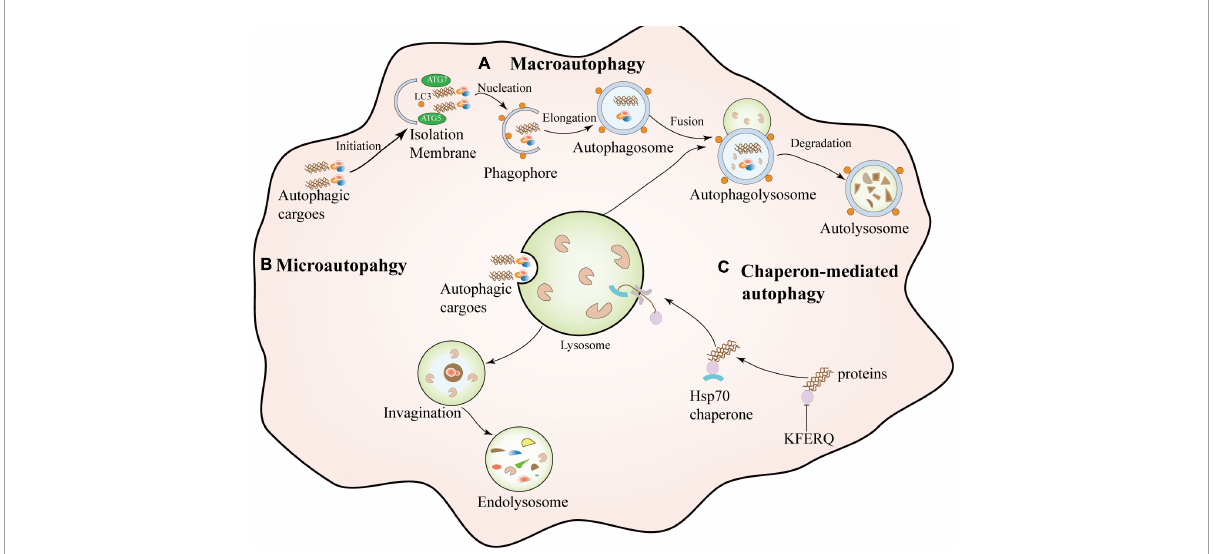
FIGURE1 Types of autophagy. Macroautophagy is a dynamic process characterized by the sequestration of cytoplasmic contents in a bilayer membrane structure, forming an intermediate structure called an autophagosome or autophagosome and then fusion with lysosomes for degradation. Microautophagy: It encapsulates contents by invagination on the lysosomal membrane to form an intrinsic vesicle followed by degradation. Chaperone-mediated autophagy (CMA) is a highly selective catabolic process that mediates specific target motifs containing CMAs. The protein (KFERQ) is dissociated by cytosolic chaperones and transferred to the lysosome for degradation through a transmembrane complex composed of lysosome-associated transmembrane protein (LAMP2A).